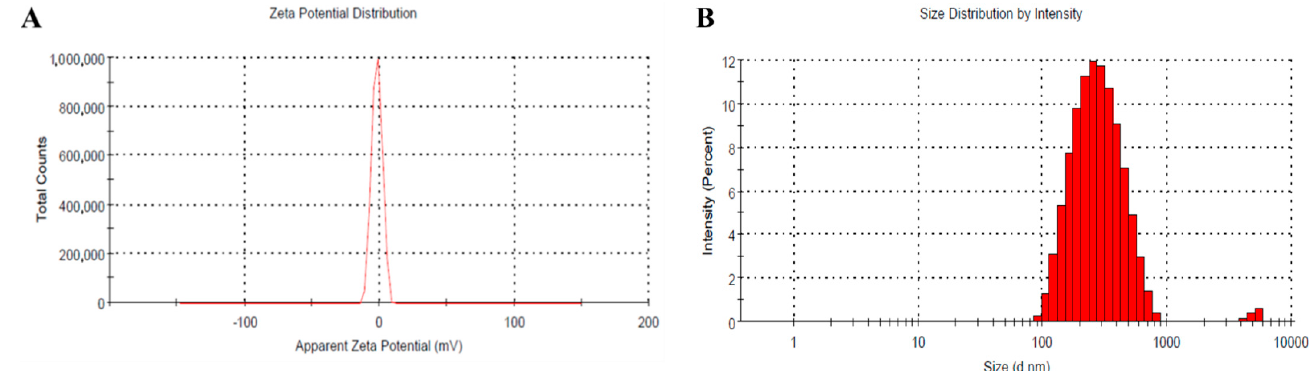
Figure 6. ( A ) Zeta potential and ( B ) particle size of optimized ATO-NLC formulation.